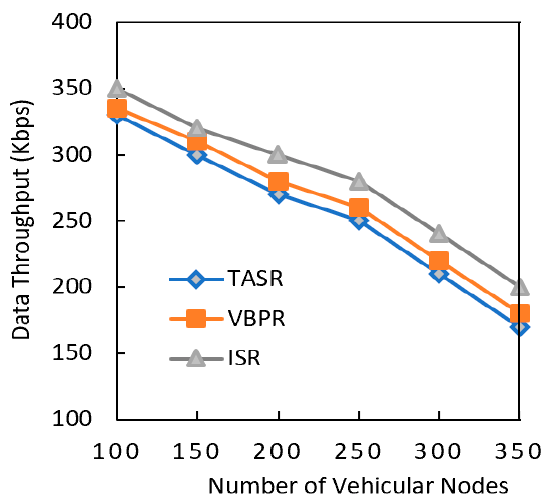
Figure 7. Comparison of data throughput with increasing number of vehicular nodes.